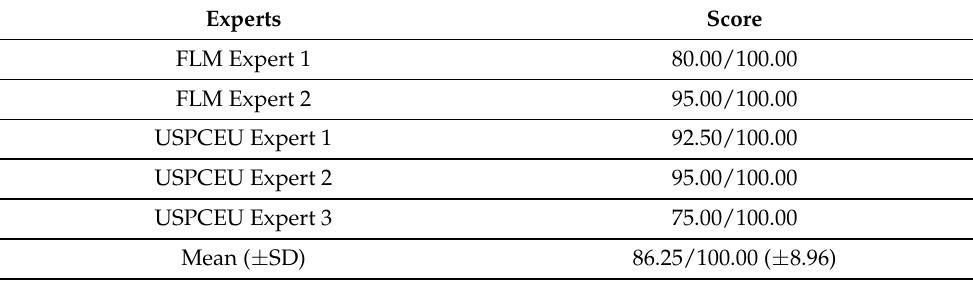
Table 9. Results of the System Usability